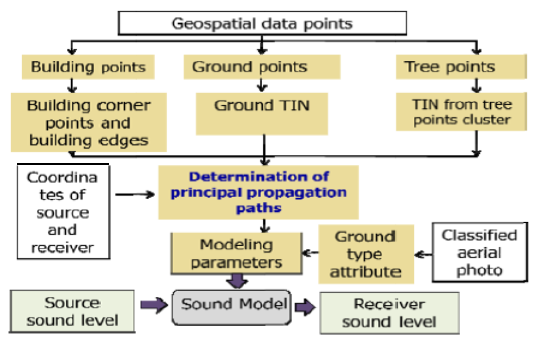
Figure 1. Flow chart showing extraction of terrain